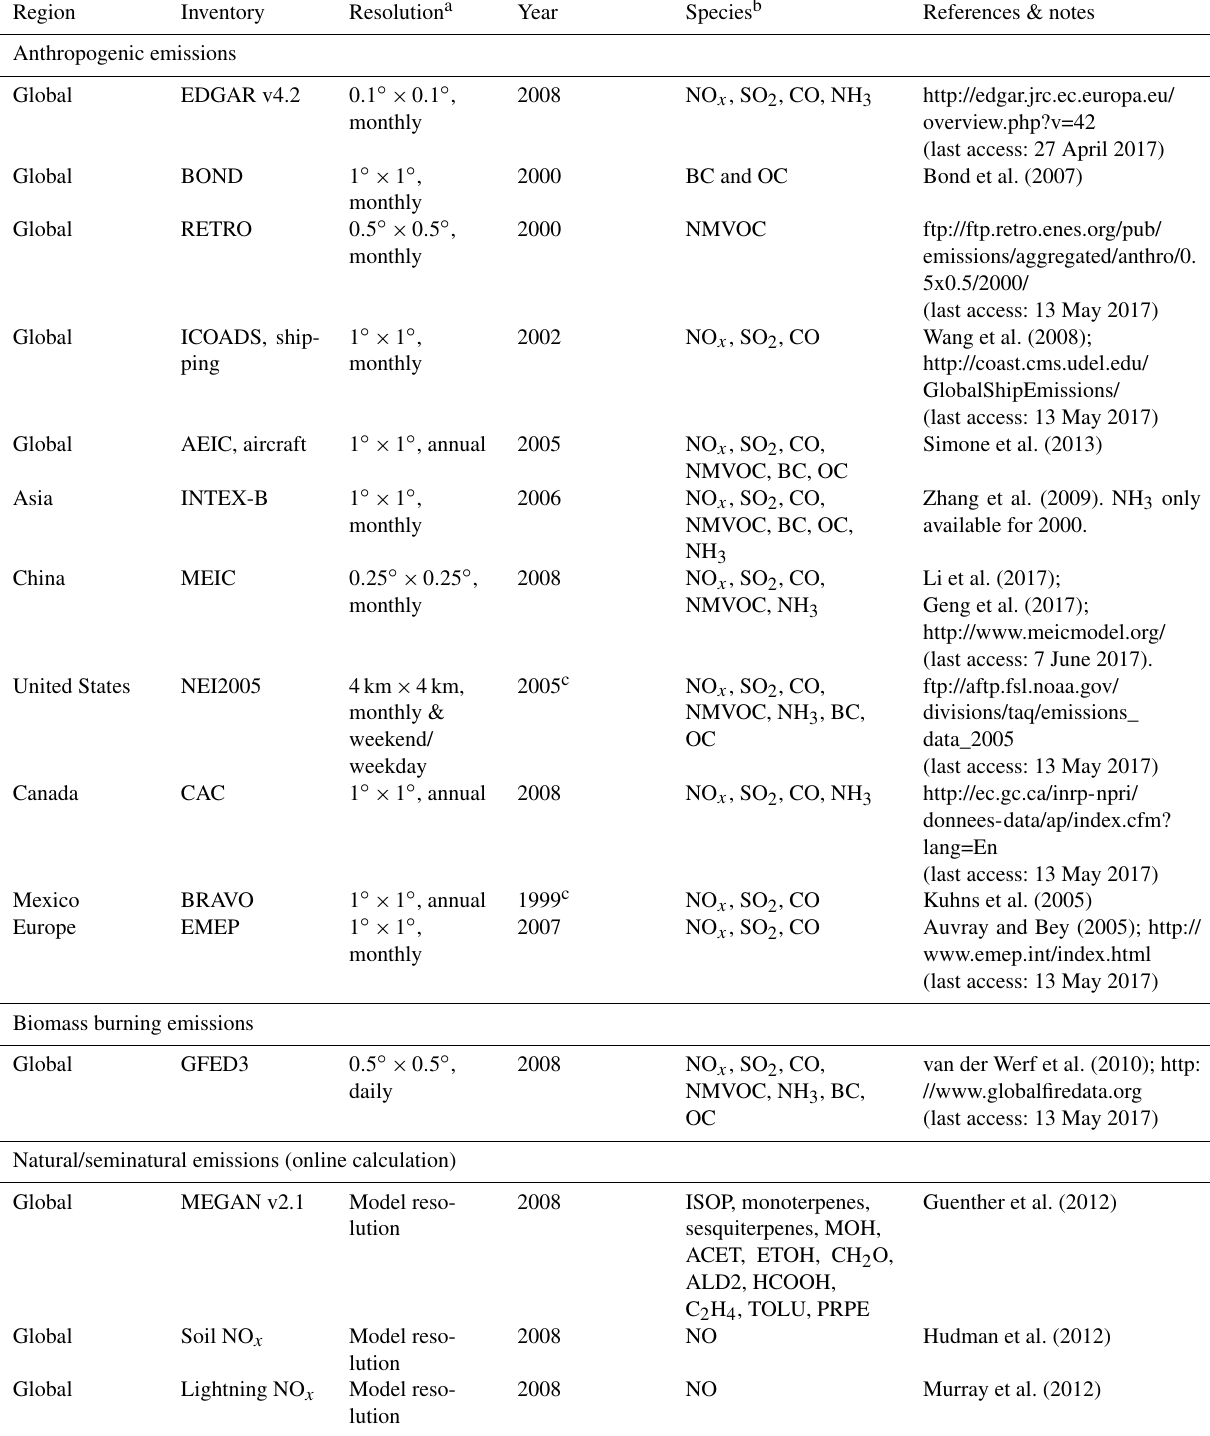
Table 1. Emissions used in the